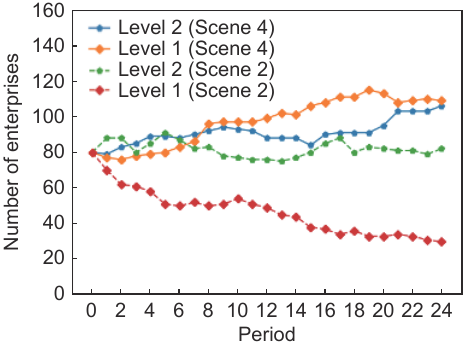
Fig. 11 Scenes 2 and 4: Changes of number of enterprises in Levels 1 and